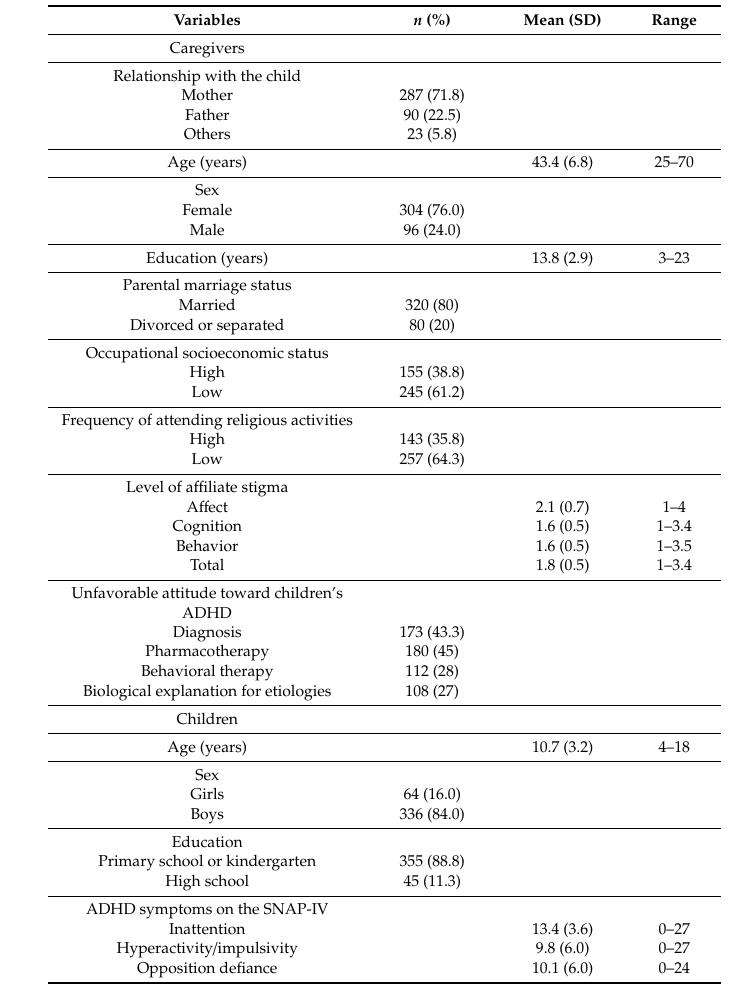
Table 1. Caregivers’ and children’s demographic characteristics, mean score on each domain of a ffi liate stigma, unfavorable attitude toward children’s attention-deficit / hyperactivity disorder (ADHD), and children’s ADHD symptoms ( N =